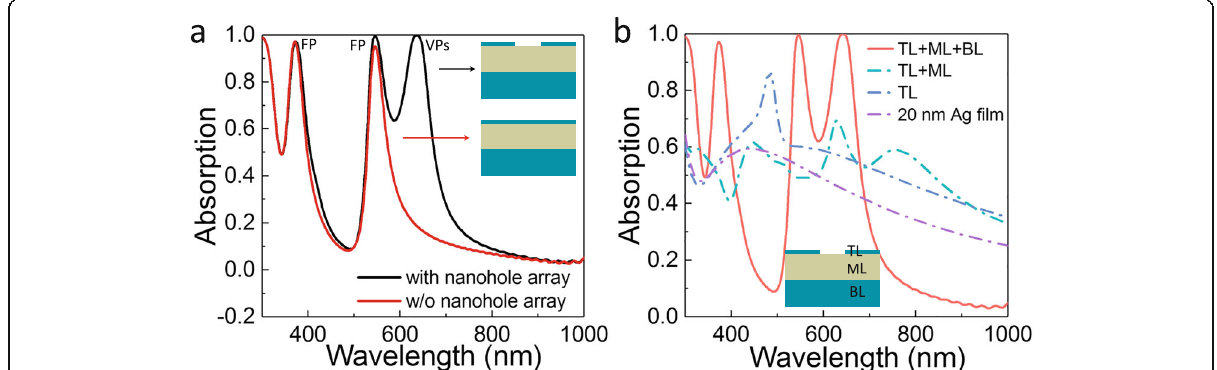
Fig. 2 a Calculated absorption spectra of the proposed nanohole array-based absorber compared with the FP absorber without nanoholes in the top layer. b Calculated absorption spectra using different combinations of three layers as well as 20 nm of silver. TL, top layer; ML, middle layer; BL, bottom layer